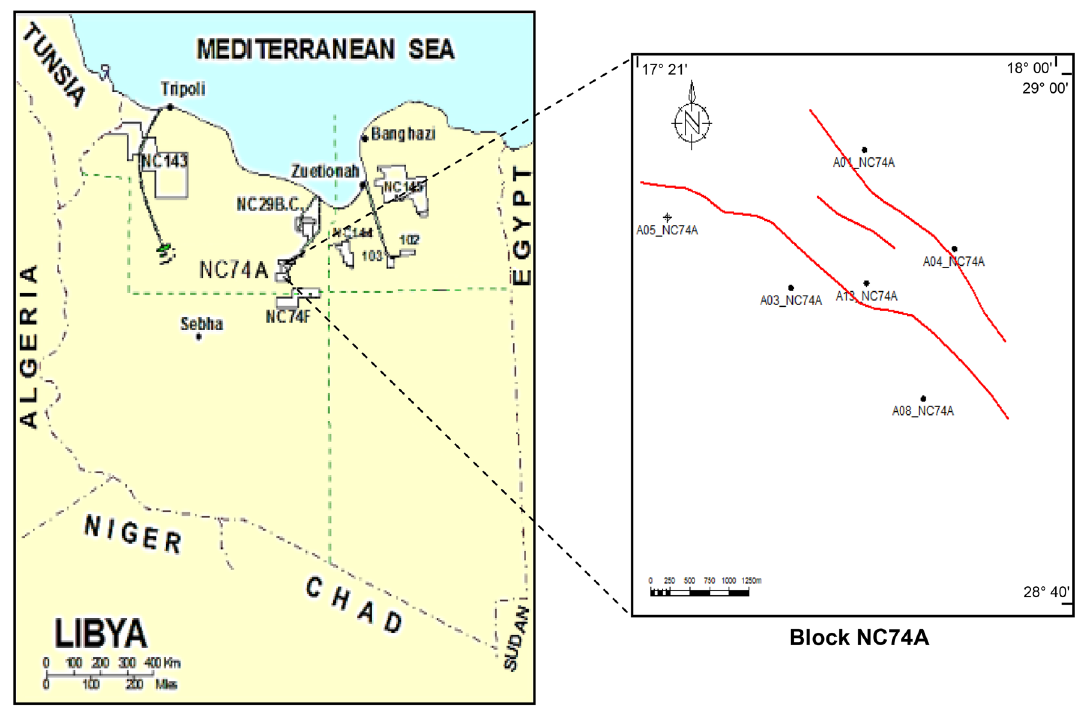
Fig. 1 Location map of Hakim